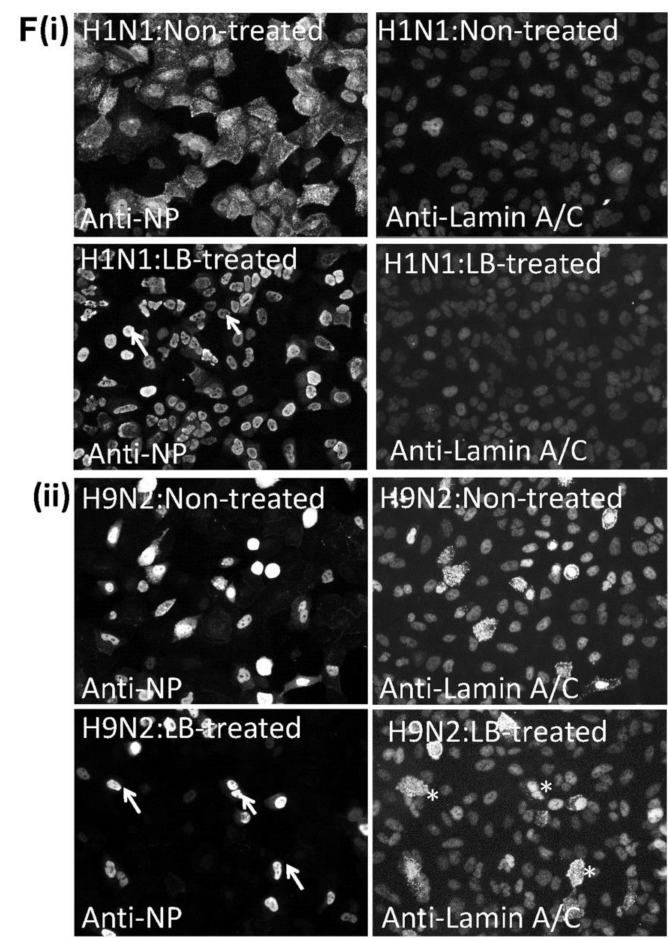
Figure 8. Altered integrity of the nuclear envelope occurs in H9N2 virus-infected A549 cells. A549 cells were infected with (i) H1N1 / WSN (H1N1) and (ii) H9N2 influenza viruses using a multiplicity of infection (MOI) of 5. At 20 h post-infection (hpi) the cells were stained using ( A ) anti-NP, DAPI and anti-lamin A / C or ( B ) anti-NP and anti-lamin B1, and examined using confocal microscopy. The location of the nucleus (N), H9N2 virus NP retained in the nucleus (**) and cytoplasmic anti-lamin A / C and B1 staining (*) are highlighted. ( C ) Cell lysates were prepared from (M) mock-infected, (H1) H1N1 / WSN virus-infected and (H9) H9N2 virus-infected A549 cells and immunoblotted using anti-lamin A / C (lA / C), anti-lamin B1 (lB1) and anti-actin (loading control). Protein species corresponding in size to lamin A / C, lamin B1 and actin are indicated. ( D ) Cells were mock-infected or infected with the H1N1, H9N2, and pH1N1 viruses, and at 12 hpi the cells were co-stained using anti-NP and anti-lamin B1, and imaged using fluorescence microscopy (objective x100 magnification). The nucleus (N) and cytoplasmic anti-NP staining (white arrow) are highlighted. ( E ) Mock-infected or cells infected with the H1N1 / WSN and H9N2 influenza virus at 20 hrs post-infection (hpi) were stained using anti-NPC (green), DAPI (blue) and anti-lamin A / C (red), and imaged using confocal microscopy. The nucleus (N) and cytoplasmic anti-lamin A / C staining in H9N2 virus-infected cells (*) are indicated. The insets are higher magnification images showing the demarcation of the nuclear envelope highlighted by the anti-NPC staining (white arrow); bar = 0.5 µ m. ( F ) Cells were infected with (i) H1N1 / WSN or (ii) H9N2 influenza virus using an MOI of 5 and at 2 hpi the cells were either non-treated or treated with leptomycin B (LB-treated). At 18 hpi the cells were co-stained using anti-NP and anti-lamin A / C, and imaged by fluorescence microscopy (objective x20 magnification). The cytoplasmic anti-lamin A / C staining in infected cells (*) and anti-NP stained nuclei (white arrows) are